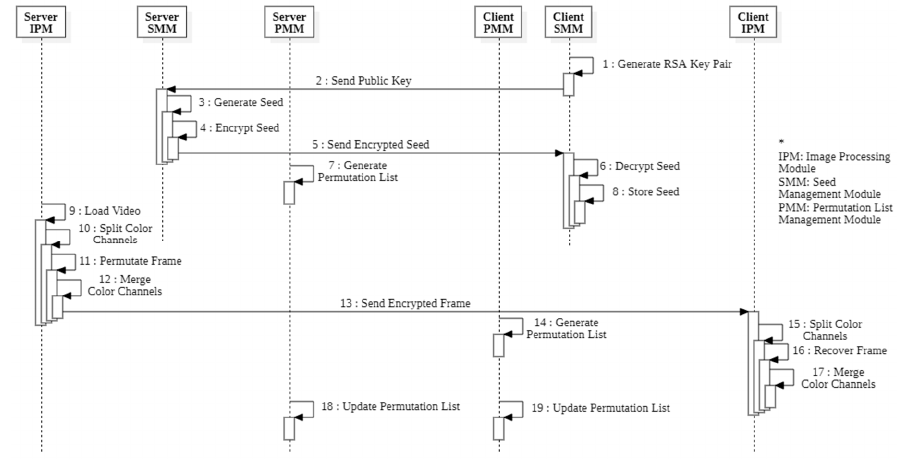
Figure 8. Proposed algorithm encryption sequence diagram.